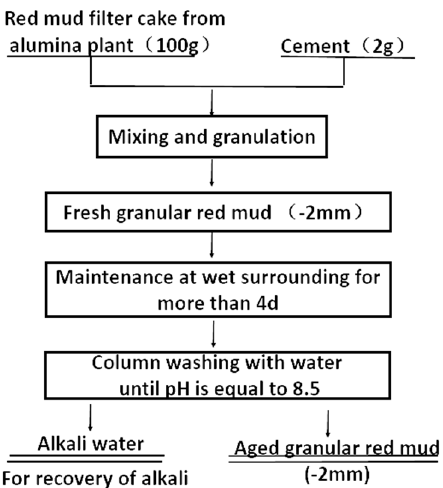
Figure 4. Preparation procedure of granular red mud (GRM) adsorbent [63]. Reproduced with permission from [63], published by The Transactions of Nonferrous Metals Society of China, 2012.